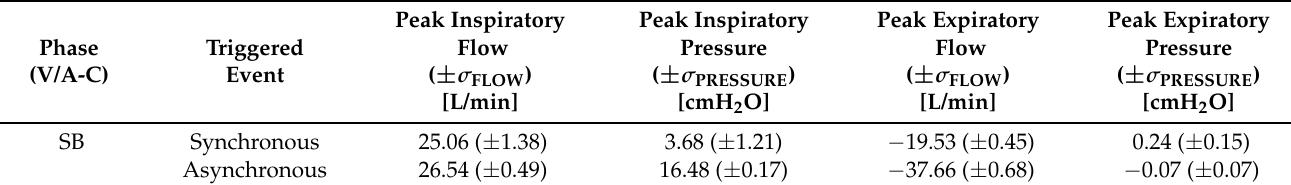
Table 3. Comparison of peak flow and pressure values for the recorded spontaneous sinusoidal breathing phase (SB) of the V/A-C mode. The mode introduced a forced inspiratory cycle (double triggering) based on the trigger event. The inspiratory and expiratory peaks are differentiated based on the trigger event. Synchronous: the lung simulator’s spontaneous breathing is in phase with the mechanical ventilator during V/A-C mode; asynchronous: the lung simulator and the mechanical ventilator are out of phase during V/A-C